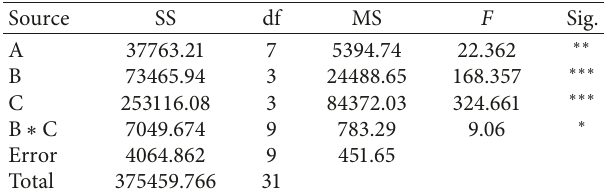
Table 2: The list of factors of the AA6061 alloy under PSC.